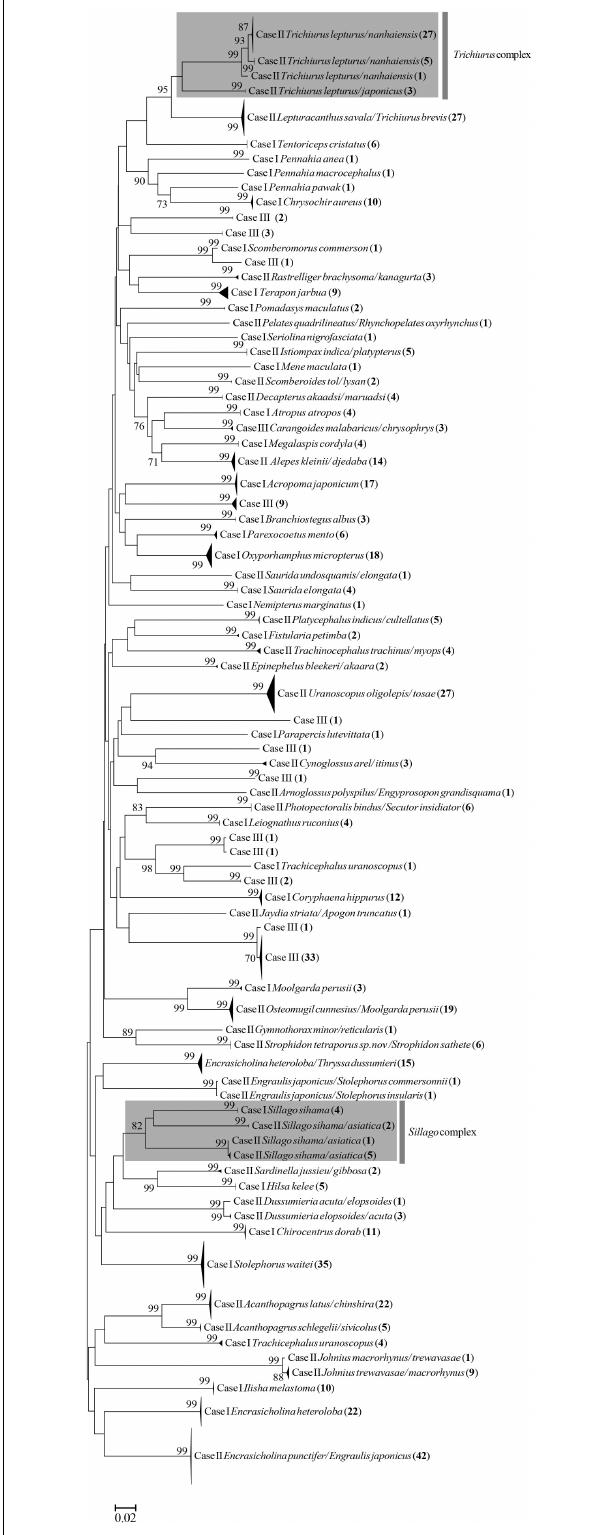
FIGURE 4 | The neighbor-joining tree of COI sequences of fish eggs. The bootstrap values are given at